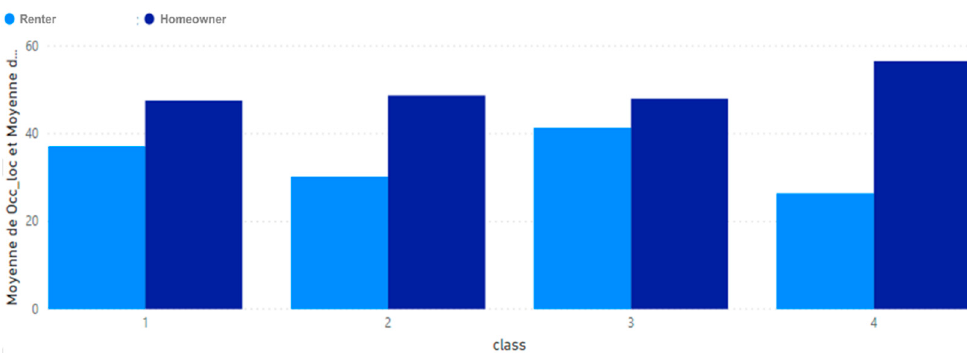
Figure 14. Occupacy status by social class.